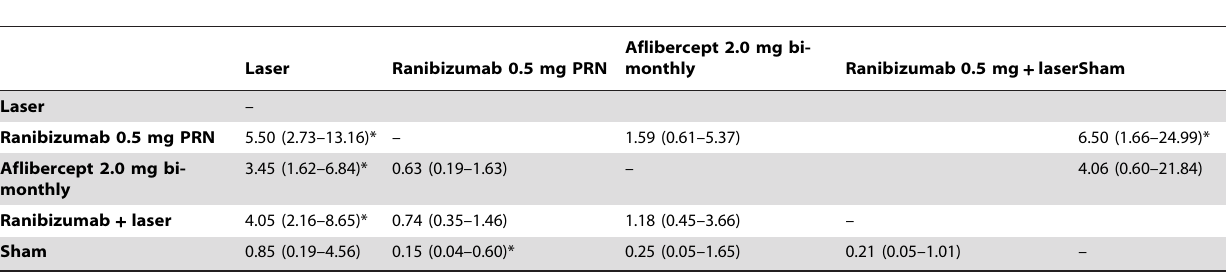
Table 2. Pair-wise odds ratios (95% credible intervals) from the random treatment effects model with baseline BVCA included as a